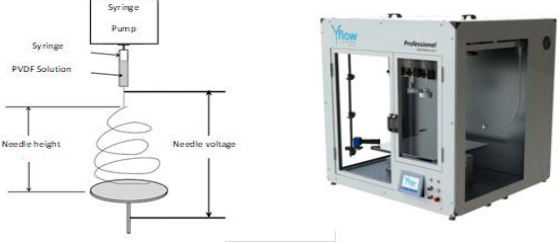
Table 1. Operating conditions of the electrospinning process.